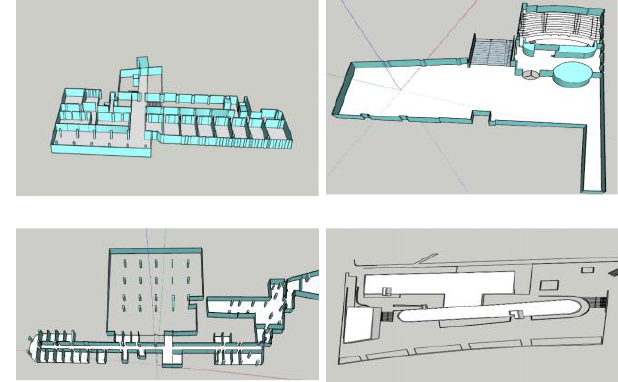
Figure 7/a. SBIF Student Building 2. Floor 3D Model, Figure 7/b. SBIF Middle Garden and Auditorium 3D Model,